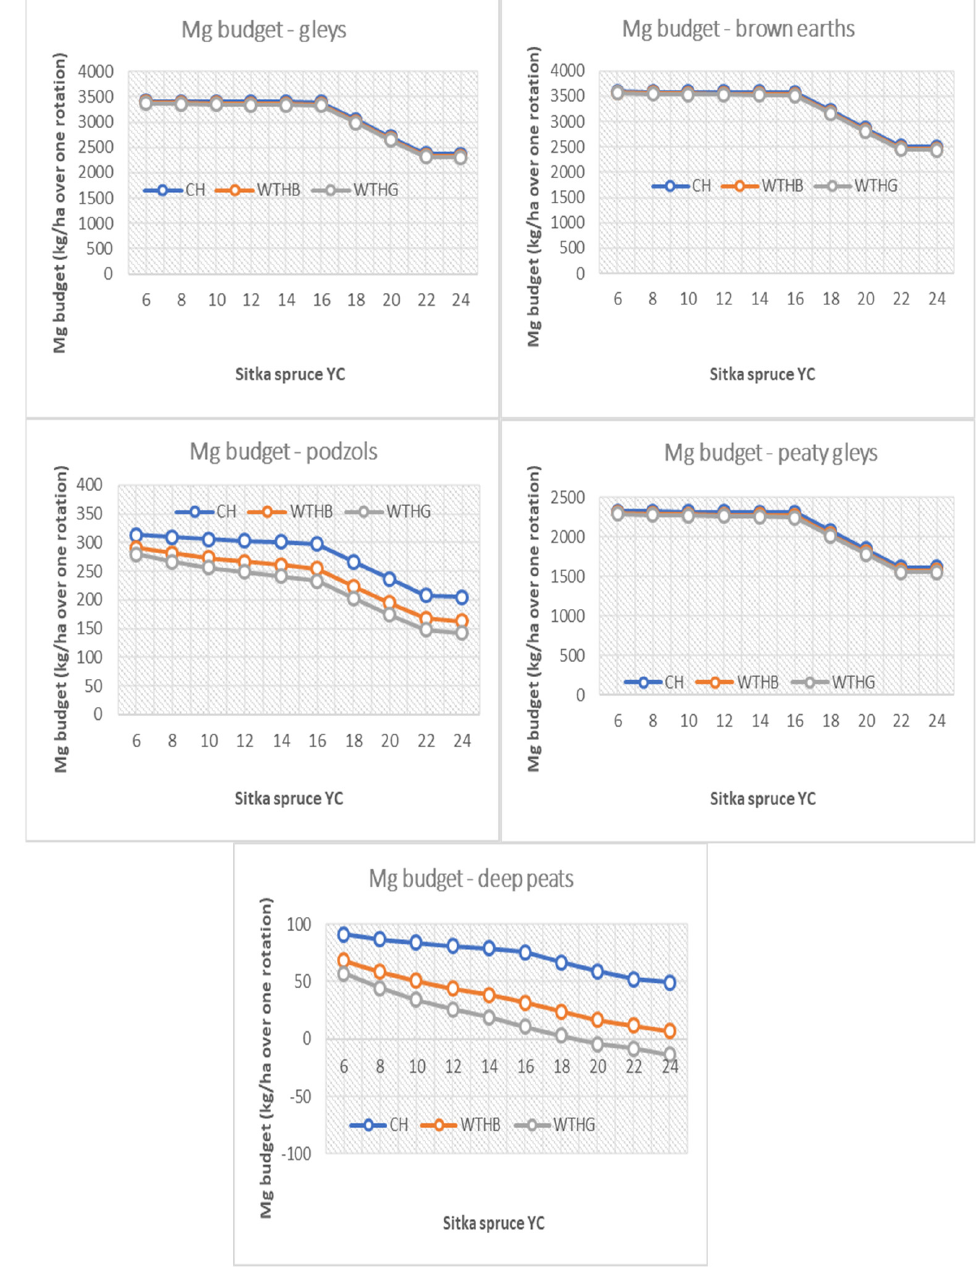
Figure 6. Forest Mg budget for Sitka spruce first rotation, YC 6-24, on five main forest soil types. The results indicate that the Ca budget is positive for both CH and WTHB scenarios on all soil types except podzols, where the budget is negative for crops of YC > 12 under WTHB management. The WTHG scenario increased the number of soil types with negative Ca balances for first rotation crops, including for YC > 20 on brown earths, YC > 8 on podzols, and YC > 18 on deep peats. In contrast, the Mg budget was positive for all three harvesting scenarios on gley (surface and ground water) soils, brown earths, podzols and peaty gleys. The only exception was the WTHG scenario for SS YC > 18 on deep peat. The K budget was positive for all three harvesting scenarios on all soil types except for deep peats, where WTHB resulted in a negative budget for YC > 16 and WTHG a negative balance for YC >